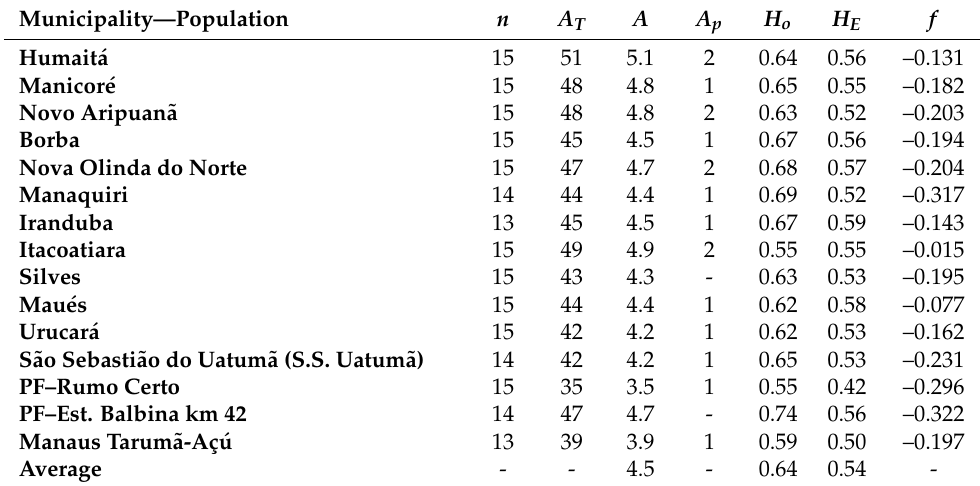
Table 1. Genetic diversity indexes at the level of the 15 populations obtained from ten microsatellite loci developed for A. aculeatum